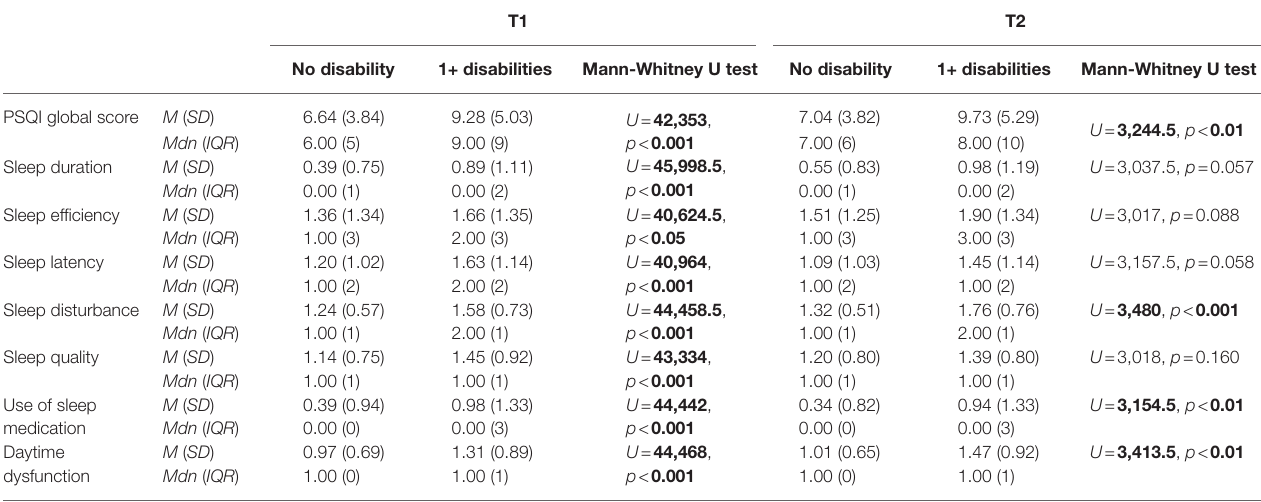
TABLE 3 | Between-group comparison of Pittsburgh Sleep Quality Index (PSQI) global and component scores for 1+ disabilities and no disability subgroups. T1